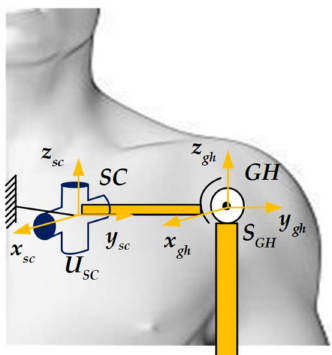
Figure 5. Simplified equivalent mechanism model of the scapula belt.